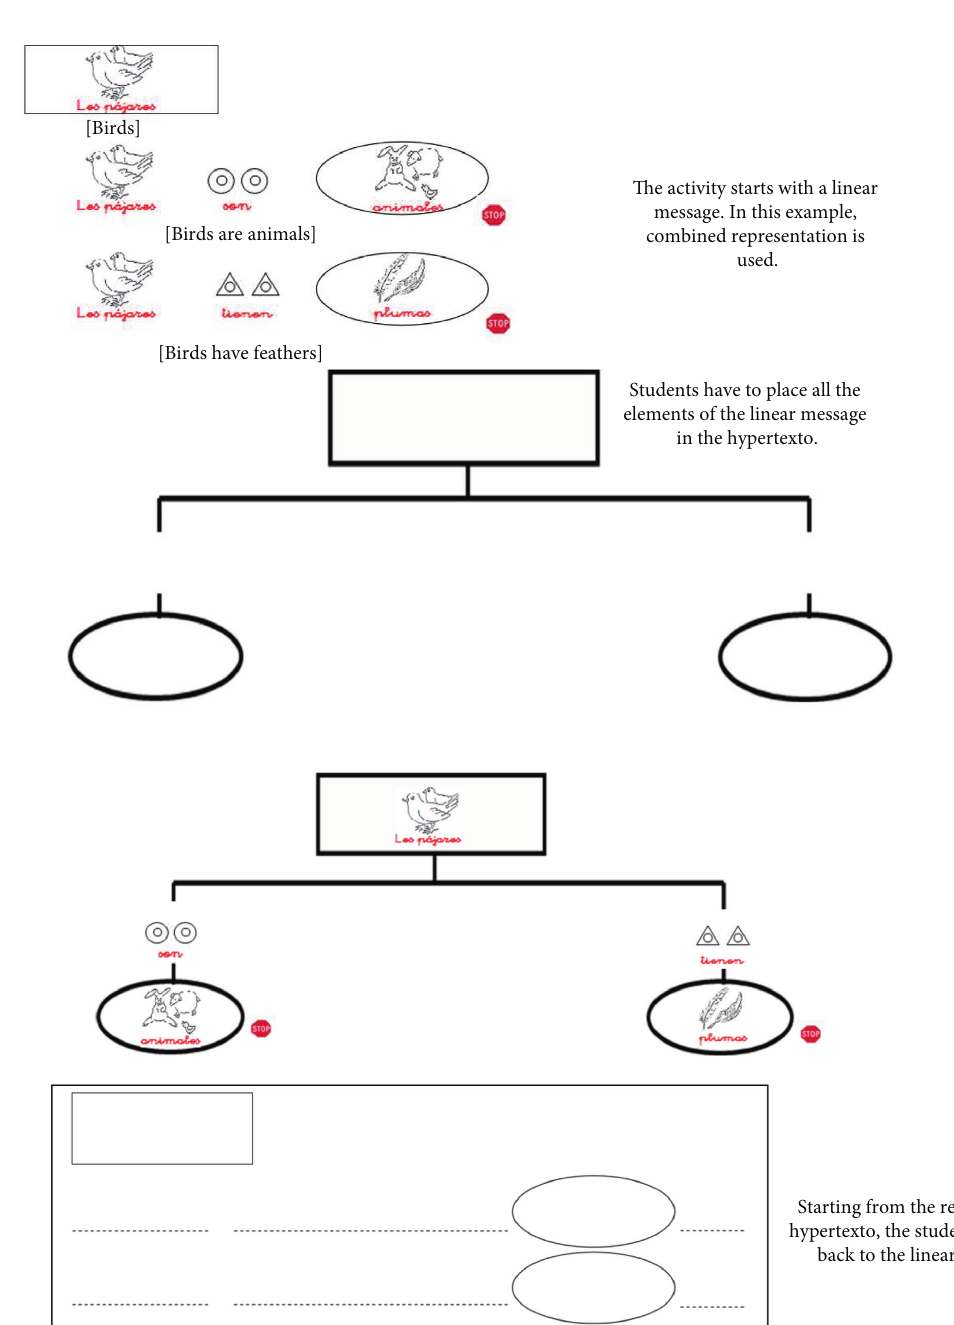
Figure 3: Example of an activity in the program EPI.com: children have to organize the information of the linear message into the Hypertexto and subsequently convert it back into linear text.